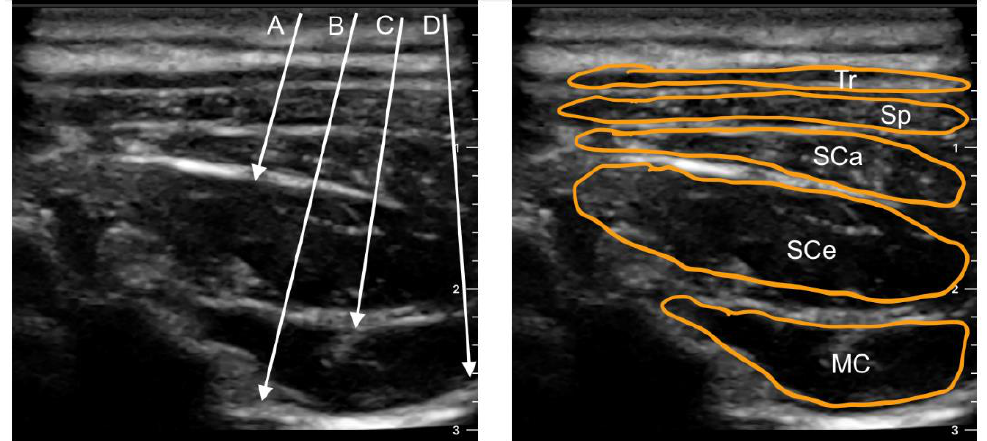
Figure 2. Transverse sonogram of the posterior neck area at the C5 level. The arrows indicate the the needle trajectories for: A—inter-semispinal plane block; B—retrolaminar cervical block; C— needle trajectories for: A — inter-semispinal plane block; B — retrolaminar cervical block; C — multifi- multifidus cervicis plane block; D—cervical erector spinae plane block. MC—multifidus cervicis dus cervicis plane block; D — cervical erector spinae plane block. MC — multifidus cervicis muscle; muscle; SCe—semispinalis cervicis muscle; SCa—semispinalis capitis muscle; Sp—splenius muscle; SCe — semispinalis cervicis muscle; SCa — semispinalis capitis muscle; Sp — splenius muscle; Tr — tra- Tr—trapezius pezius muscle.